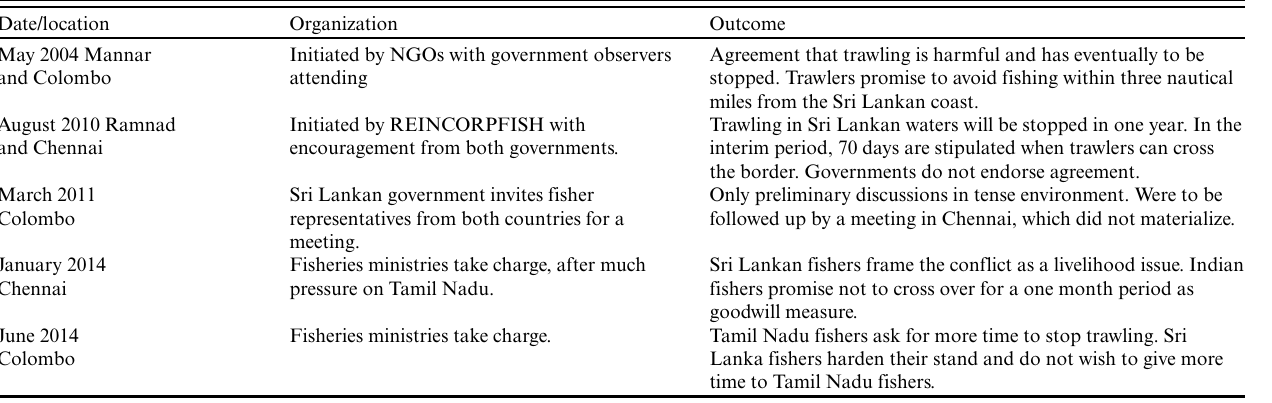
Table 2 . Overview of fisher-to-fisher dialogues in the period